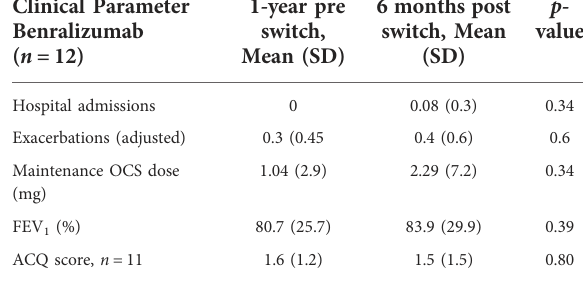
fi ve clinical parameters measured in this study 1 year before switching from reslizumab to benralizumab to the mean values of the same parameters 6 months after